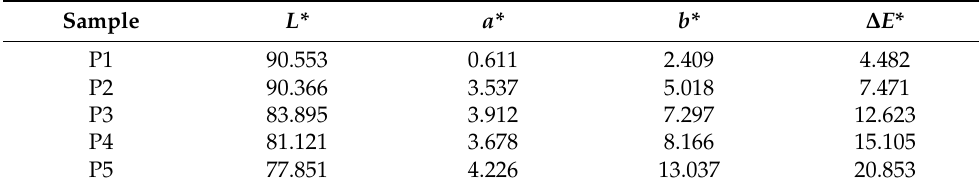
Table 2. Color analysis of pectin-based biocomposite